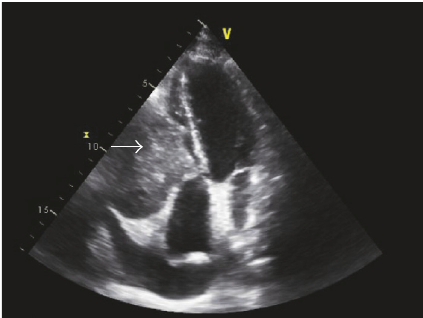
Figure 2: 2D echocardiogram of the heart in apical four chamber view showing a right ventricular mass (arrow) arising from the free wall.